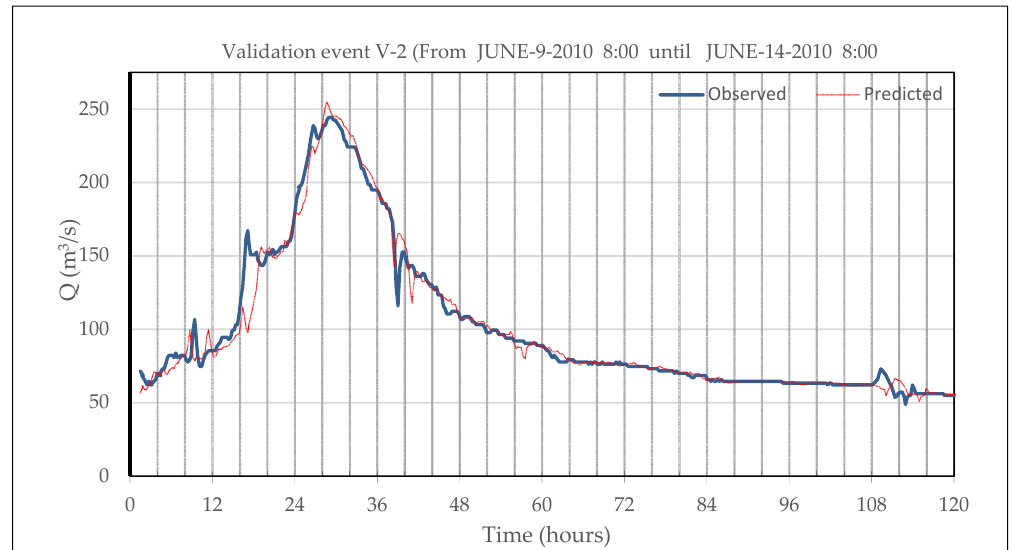
Figure 8. Comparison of 2 h lead time flow forecasts and observed outflows at the Graus station (validation event V3).